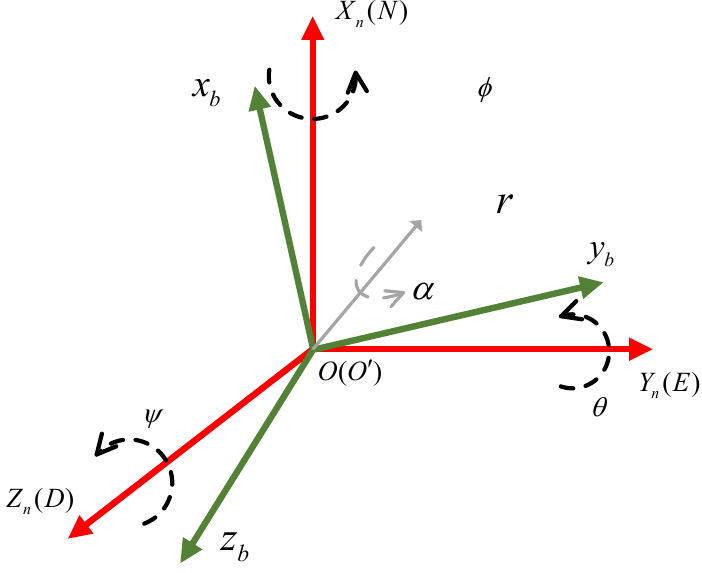
Figure 1. Carrier coordinate system and navigation coordinate system.